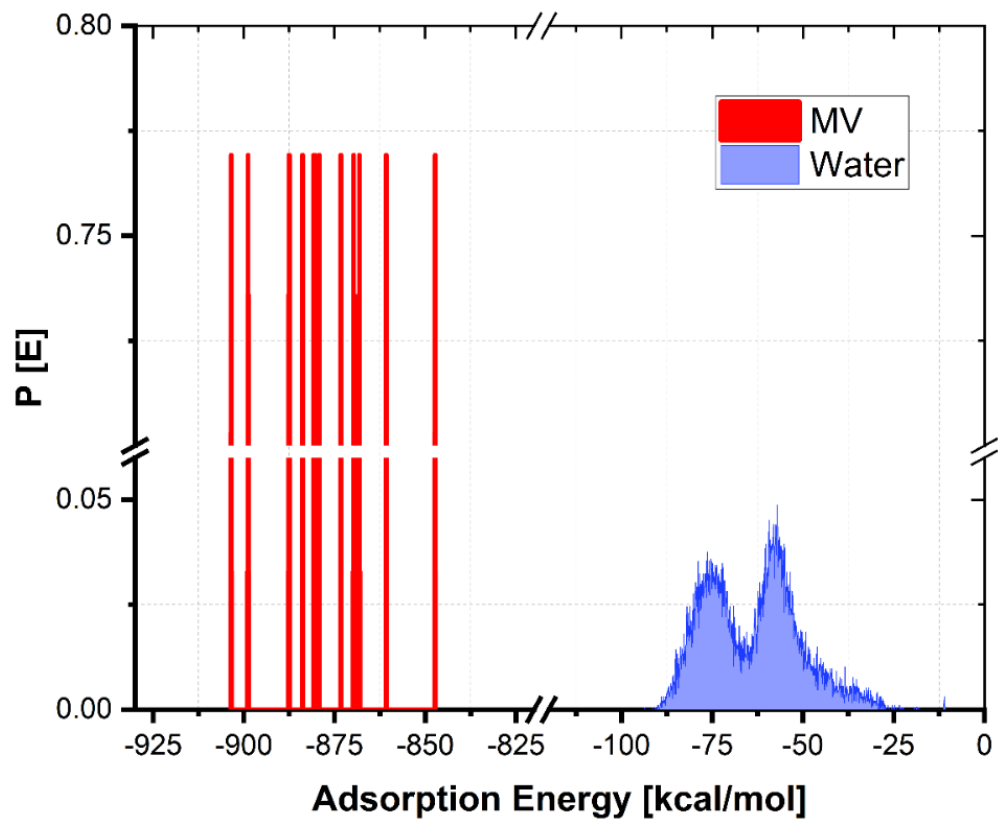
Figure 11. Distribution of adsorption energies for MV onto the halloysite surface. The Adsorption Energy ( E ads ) values for the adsorption of MV onto the HNC surface are presented in Table 6. Table 6. The distribution E ads values for MV onto the Halloysite surface. Molecule